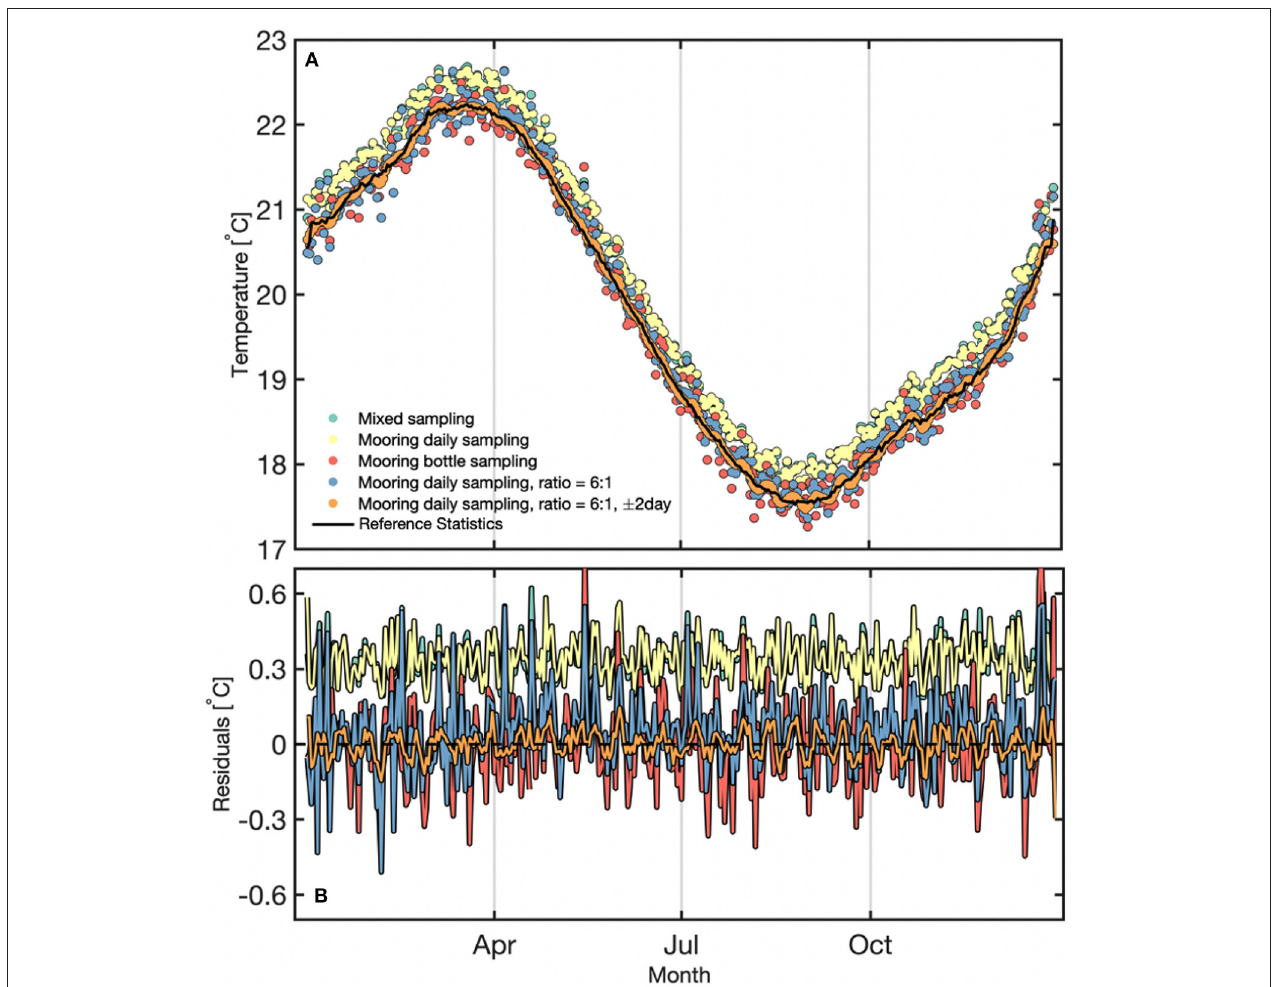
FIGURE 8 | (A) Comparing synthetic daily temperature climatological means produced using different methods (described in section 4.3) between 17 and 21m depth. The black line indicates the synthetic temperature climatology reference statistics. (B) The synthetic temperature residuals (or bias) between the daily reference statistics and each synthetic daily temperature climatology produced using different methods at the same depth range.